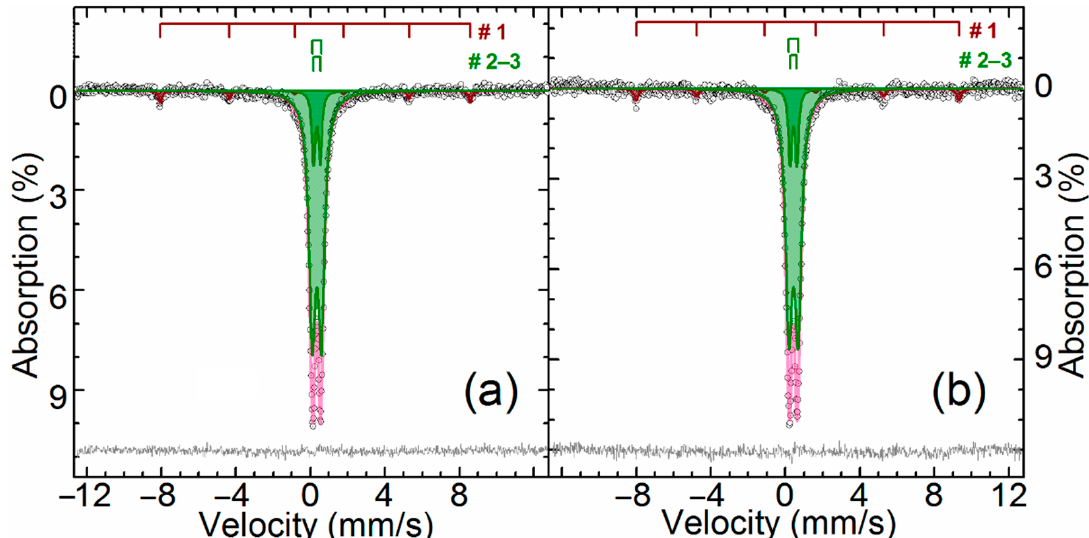
Figure 2. The Mössbauer spectra of the ZPR sample obtained at 296 K ( a ) and 78 K ( b ).